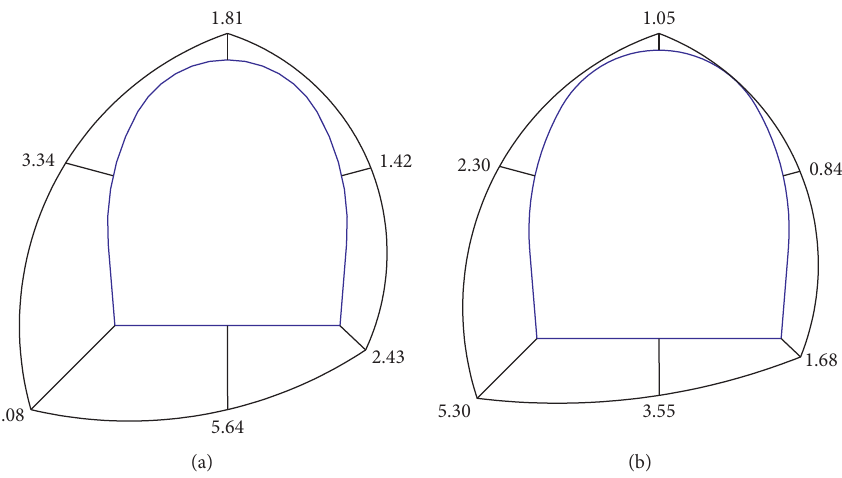
Figure 3: The envelope diagram of the vibration velocity of existing tunnel: (a) condition 1 and (b) condition